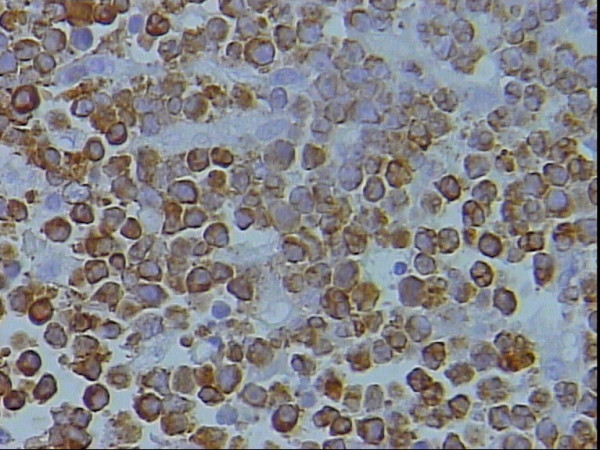
Bcl-2 membranous staining of the neoplastic lymphocytes, DAB, Hx, × 40.